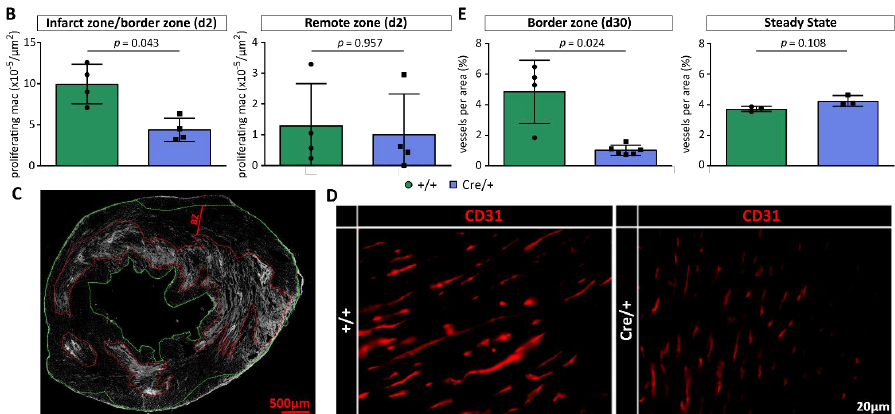
Figure 5. Decreased Rxr α expression is linked to a reduction in macrophage proliferation and vessel density in the heart after I/R injury. ( A ) IF staining to detect proliferating macrophages (F4/80: macrophage marker, Ki-67: proliferation marker, Hoechst: nuclear counterstain); ( B ) com- parison of proliferating cardiac macrophages on d2 after MI between Cx3cr1 ∆ Rxr α and control mice; ( C ) wheat Germ Agglutinin staining to detect the IZ using a WGA-Alexa Fluor™ 350 conjugated antibody; ( D ) visualization of cardiac vessel density using a CD31 antibody; ( E ) quantification of cardiac vessel density in the border zone on d30 after MI in Cx3cr1 ∆ Rxr α compared to control mice. Flowchart was created with BioRender.com. BZ: border zone; control (+/+): control mice [littermates with a floxed Rxr α allele but without Cre expression]; Cx3cr1 ∆ Rxr α (Cre/+): mice with a floxed Rxr α allele and Cre expression; IF: immunofluorescence microscopy; I/R injury: Ischemia/Reperfusion injury; IZ: infarct zone; mac: macrophages; MI: myocardial infarction; Rxr: Retinoid X receptor; WGA: Wheat Germ Agglutinin. Biomedicines 2022 , 10 , x FOR PEER REVIEW